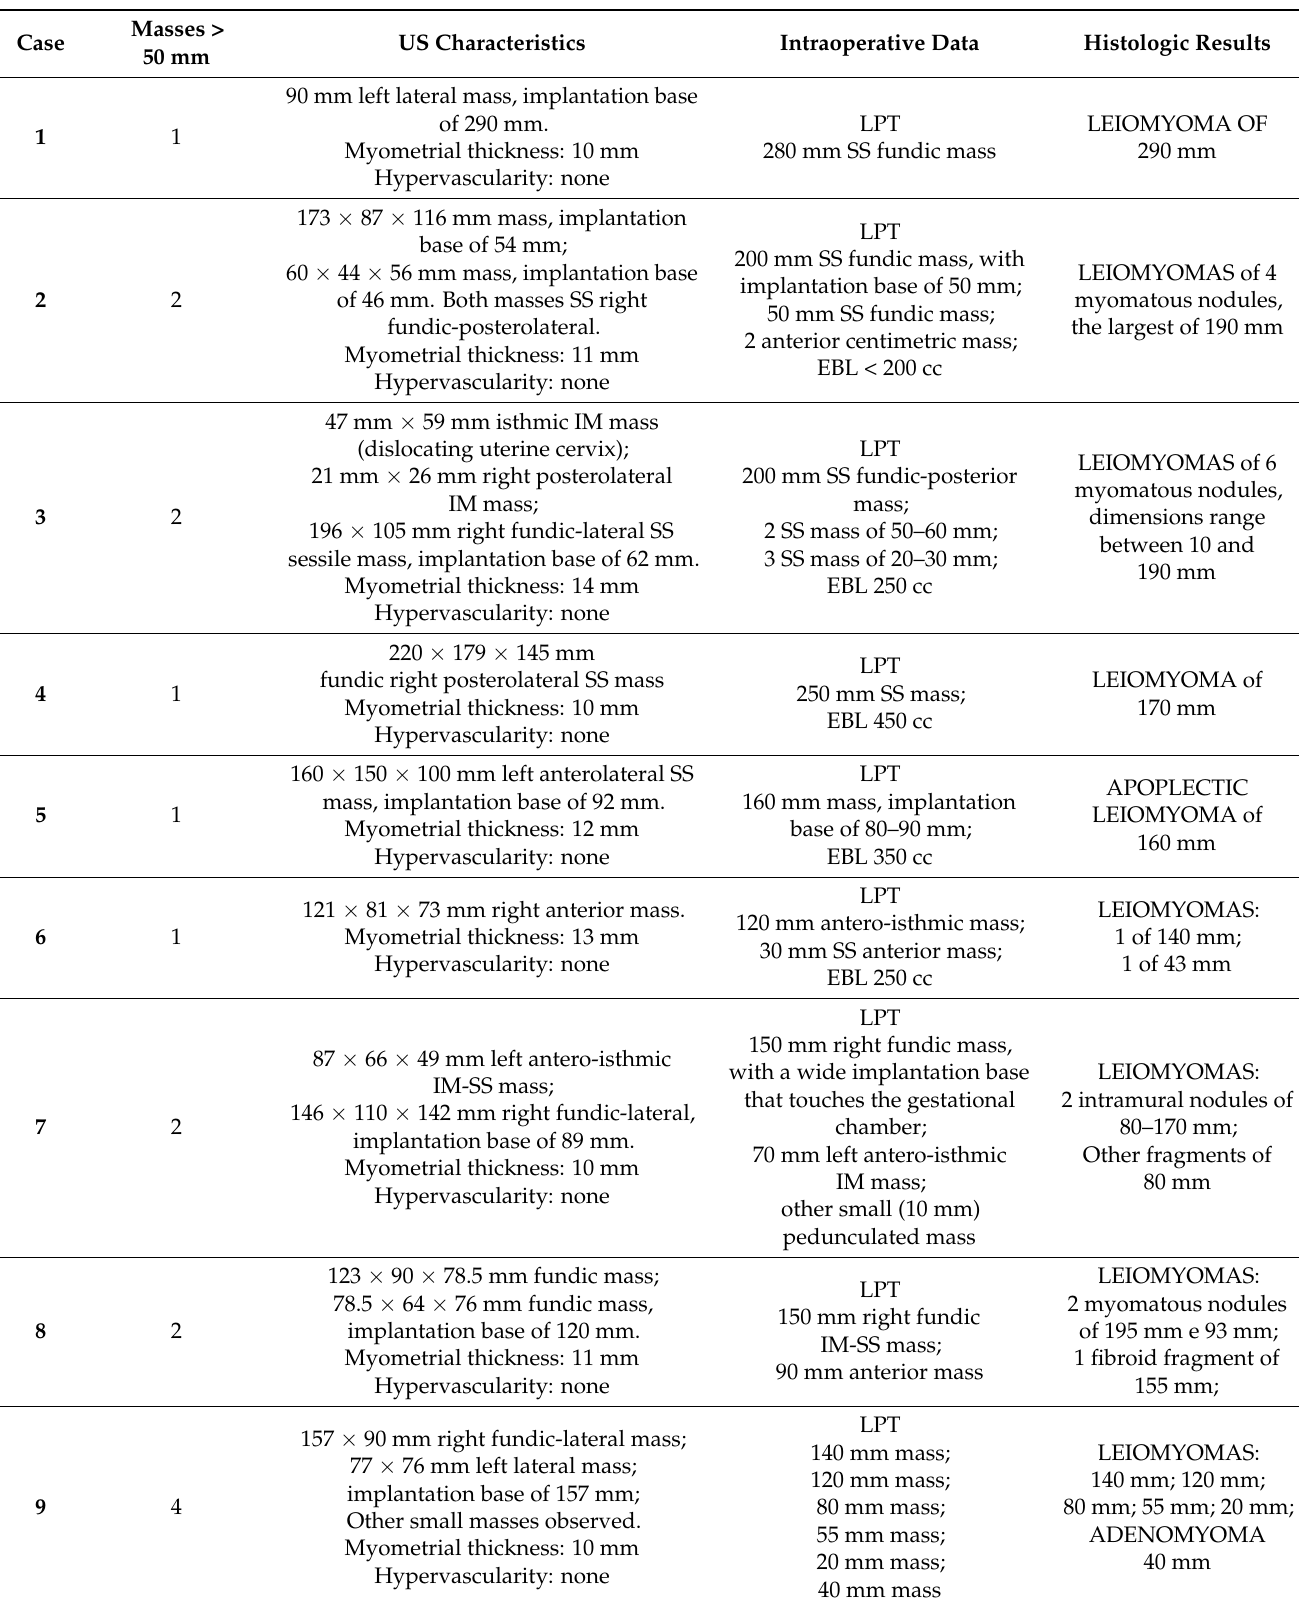
Table 2. Preoperative, intraoperative and postoperative characteristics of masses (SS: subserous; IM: intramural; EBL: estimated blood